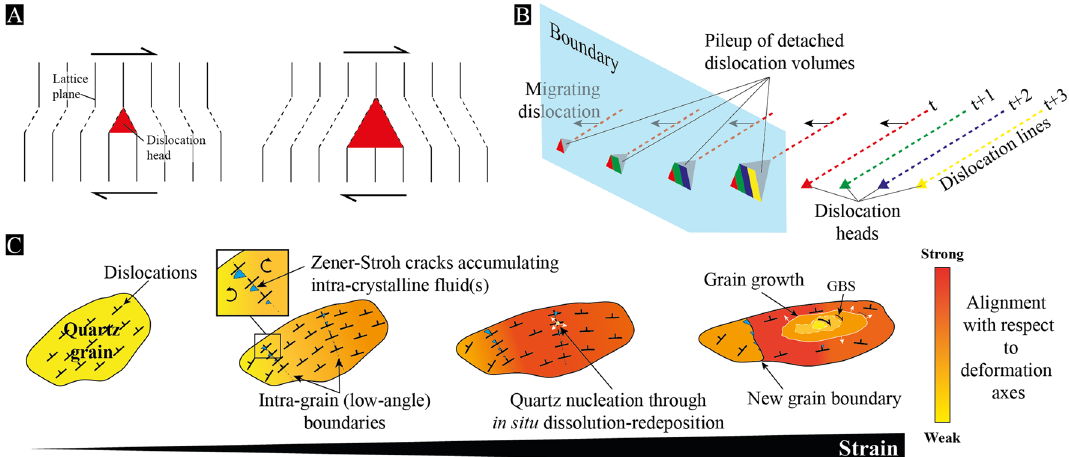
Figure 9. Model of micro-pores induced by coalescing dislocations during sub-grain rotation. ( A ) Mechanism of Zener-Stroh cracking to produce micro-pores by coalescing dislocations (modified after Weertman 38 ). ( B ) Sketch of migrating dislocations that stop at an interface, here envisaged as a low-angle boundary, to produce micro-pores with lattice-controlled geometries and gradual sizes along the boundary. The color scheme refers to dislocation heads that coalesce and produce growing micro-pores at several time (t) increments. ( C ) Cracking and phase nucleation induced by sub-grain rotation during plastic flow of pure quartz aggregates. While quartz deforms by crystal plasticity, low-angle boundaries arise from a first dislocation slip-system, giving rise to sub-grains that rotate to produce micro-pores through intersection with a second slip-system. In this model, pores open by coalescing dislocation along a low-angle boundary until complete recrystallization of the sub- grain. Randomly oriented quartz grains are also expected to nucleate through in situ dissolution-redeposition 45 from the collected intra-crystalline fluid into pores. New grains then subsequently rotate (GBS) and deform while they grow to align with the deformation axes. We further anticipate micro-pores to accumulate at grain boundaries, leading to rock